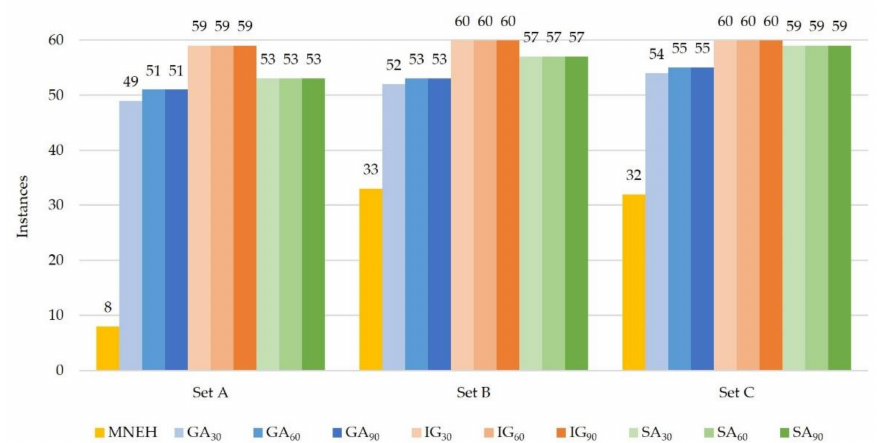
Figure 11. Number of instances that heuristic solutions are better than or equal to CPLEX solutions.